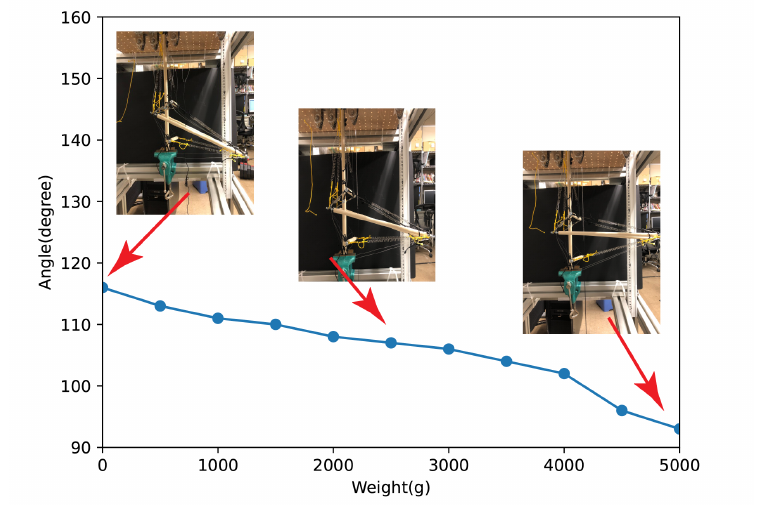
Figure 16. Graph of the angle between the upper arm and the lower arm when it is pulled upward by weights. Angles are measured based on images taken from a fixed camera. The embedded images show the states corresponding to the weights.